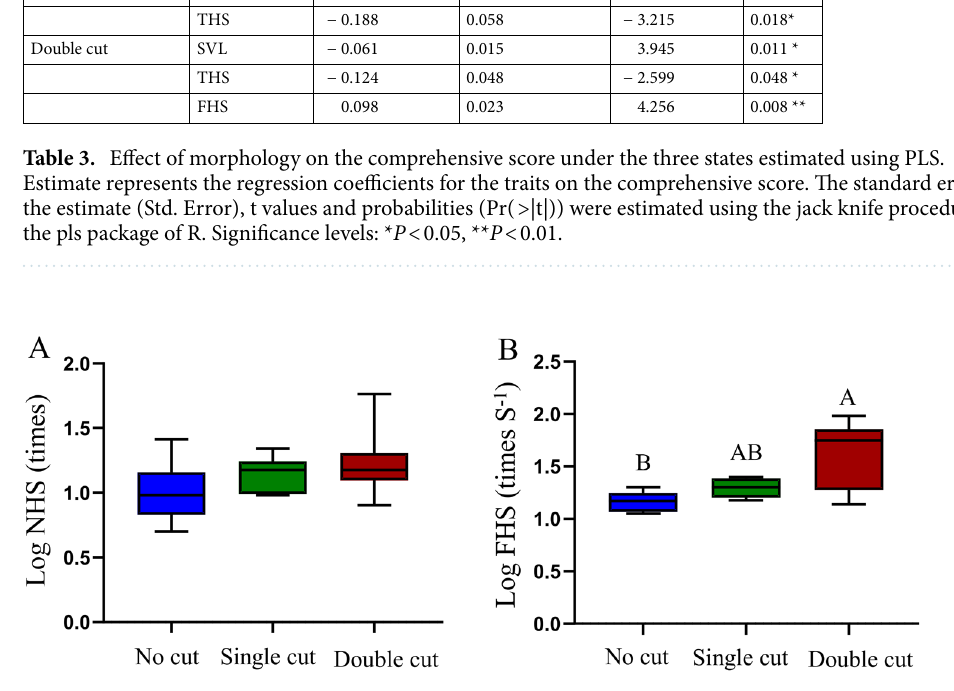
Figure 5. Log-transformed from the number of hind-limb swings ( A ) and log-transformed from frequency of hind-limb swing ( B ) of Phrynocephalus mystaceus with different fringe states. Note Different uppercase letters indicate extremely significant differences at the P < 0.01